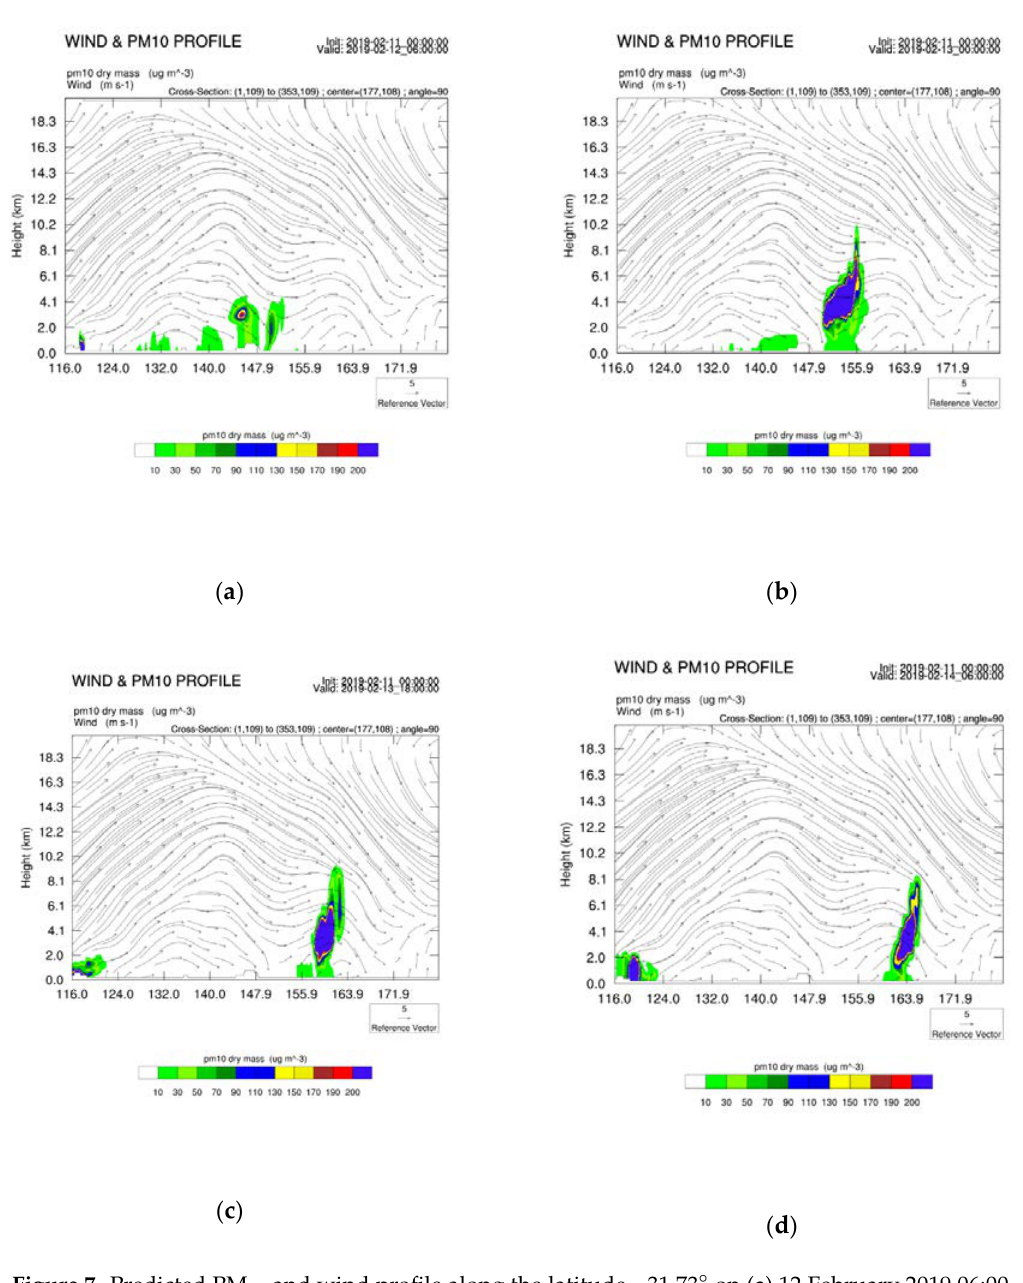
Figure 7. Predicted PM 10 and wind profile along the latitude − 31.73 ◦ on ( a ) 12 February 2019 06:00, ( b ) 13 February 2018 00:00, ( c ) 13 February 2019 18:00, and ( d ) 14 February 2019 06:00 UTC. The vertical topographic outline at the bottom of the graphs shows the Great Dividing Range in the middle, with the western plain on the left and the Tasman Sea on the right.